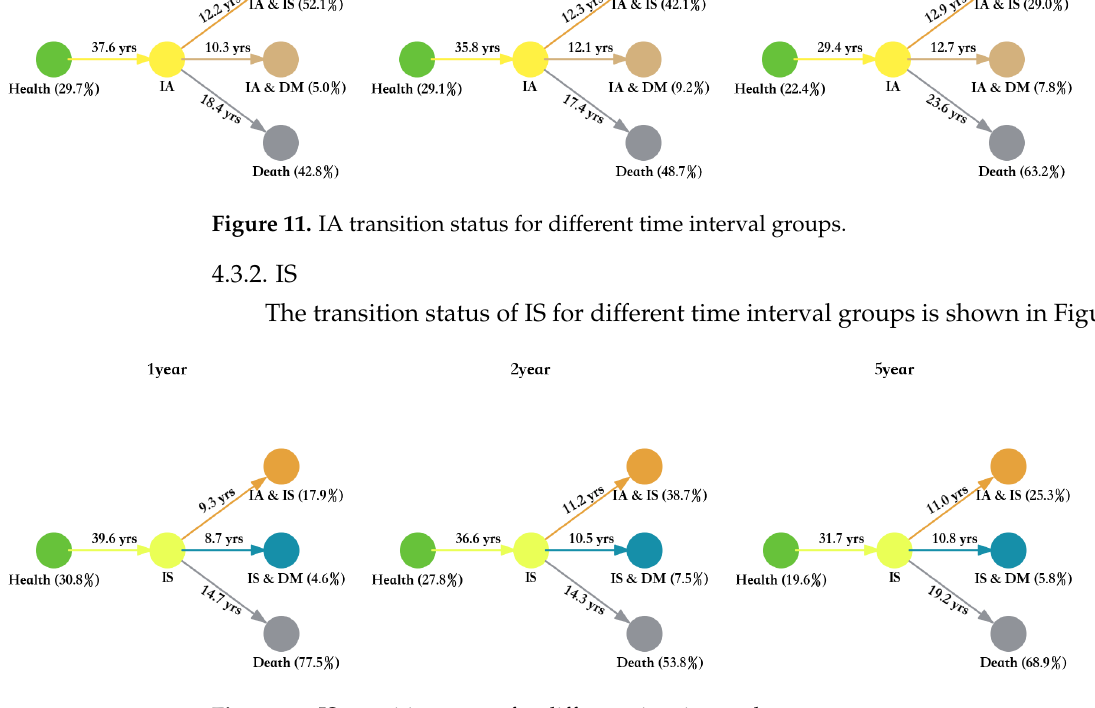
Figure 12. IS transition status for different time interval